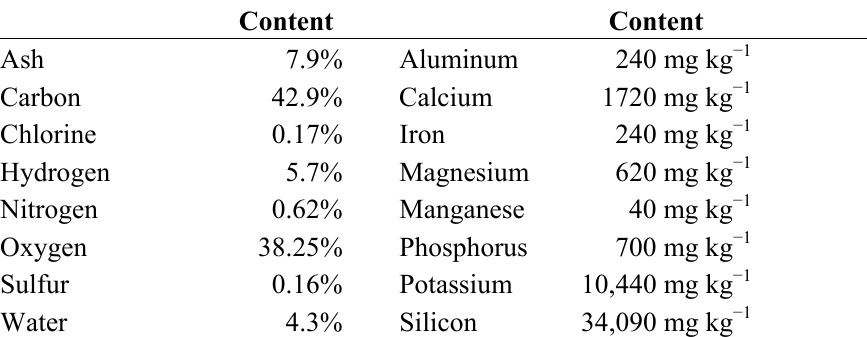
Table 2. Chemical composition of wheat straw from